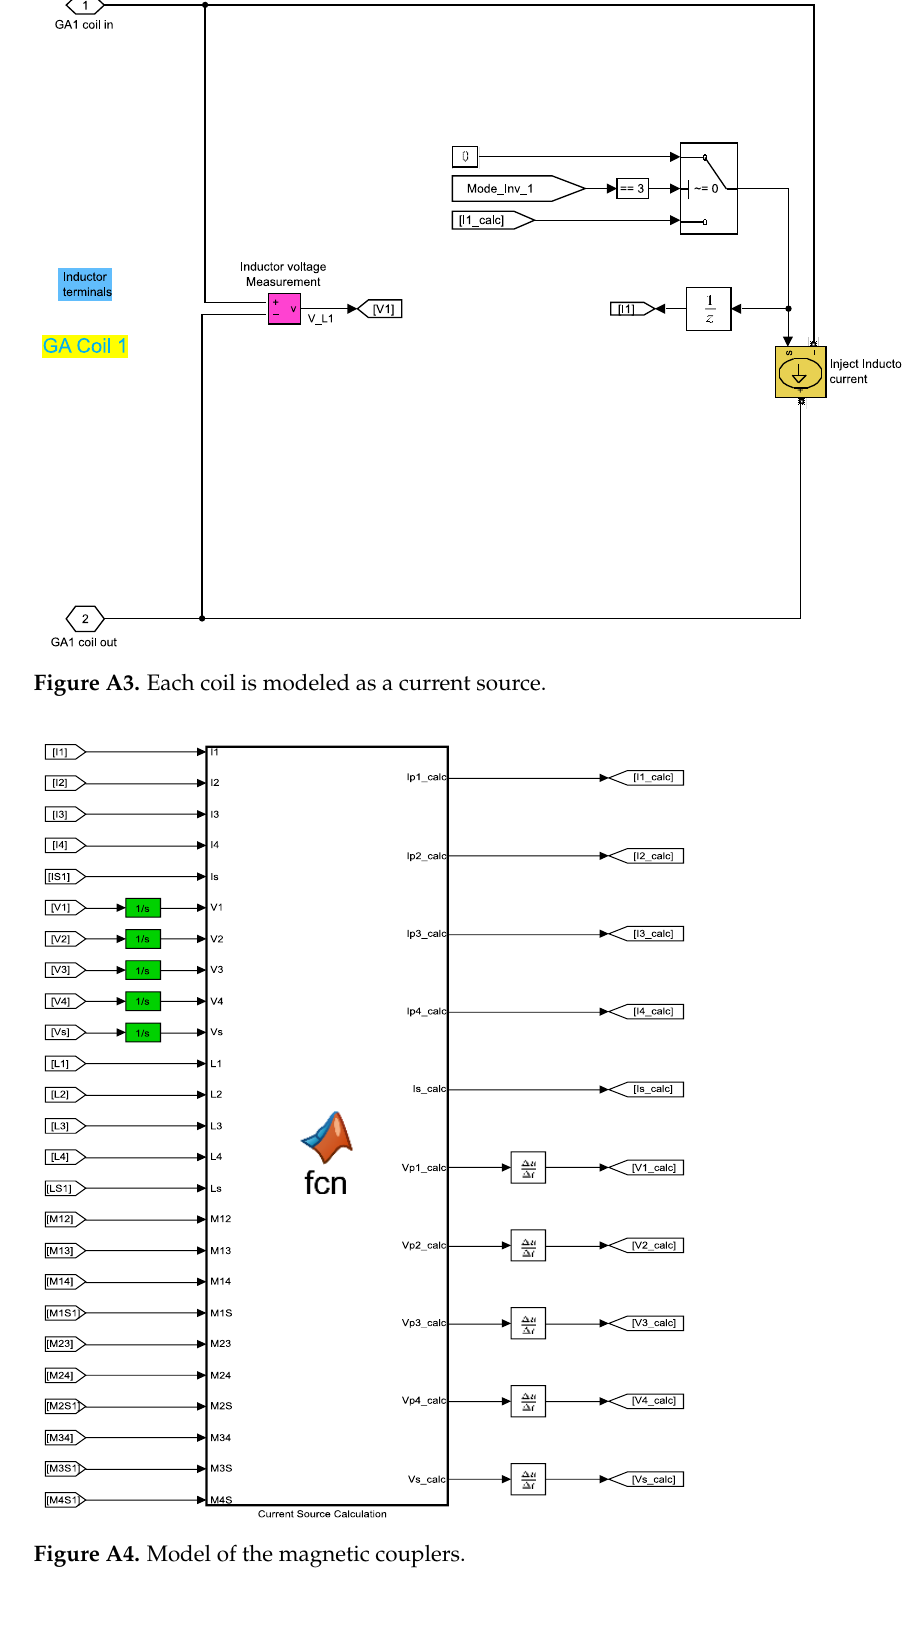
Figure A5. The following rectifier is used on the secondary side.